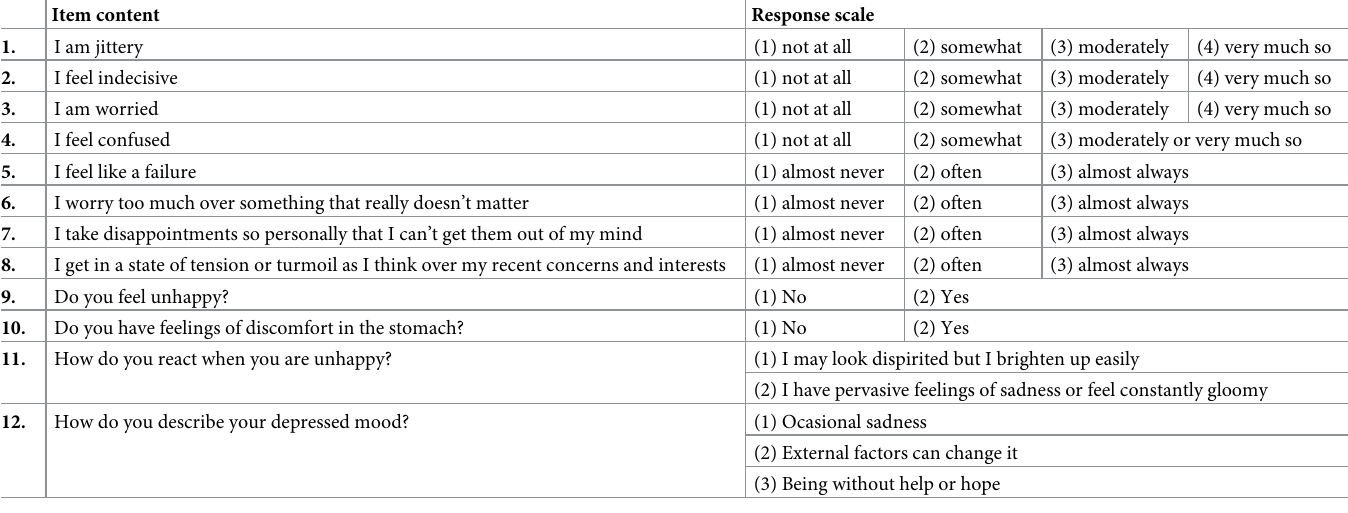
Table 1. The refined version of B-MEPS tool. Instruction to patients: “These questions aim to assess your feelings of stress related to the perioperative period”. Item content Response